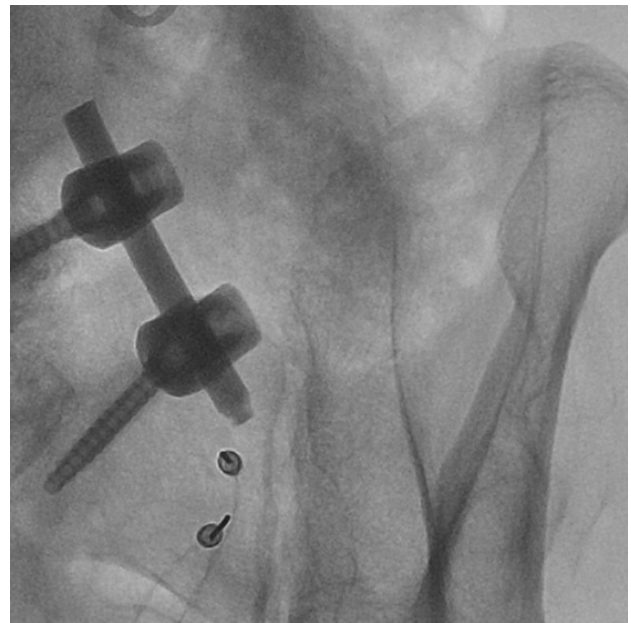
Figure 1. An example of a level of cannulae placement.